Question: Summarize what this figure shows in one sentence.
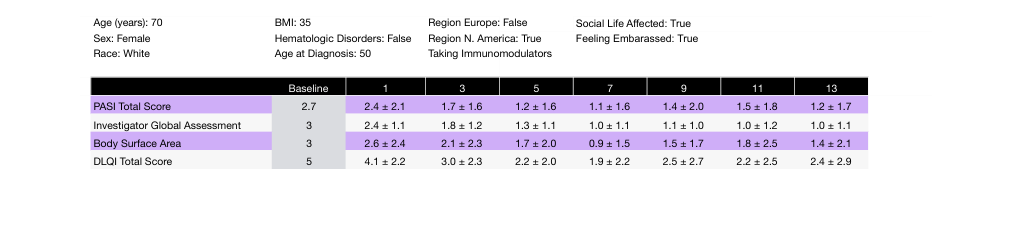
Answer: An example twin record for a single PSO patient is shown, which reports the mean and standard deviation of the twins for that patient. A sample of static baseline information is given at the top of the record. A sample of longitudinal outcomes predicted by the model are supplied as rows, with columns indicating the time in months since baseline visit.